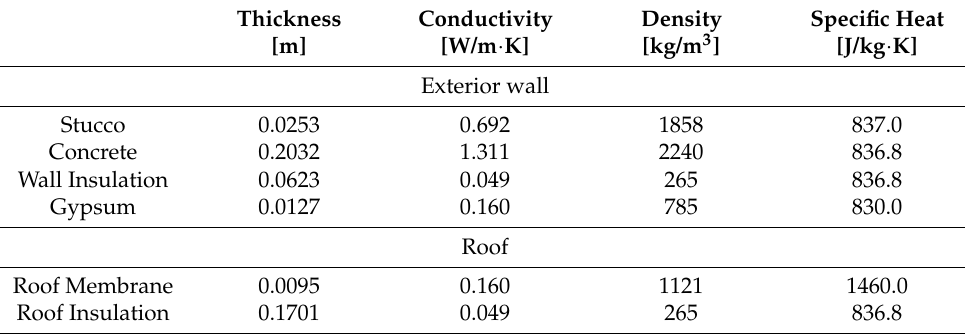
Table 1. Material composition of exterior walls and